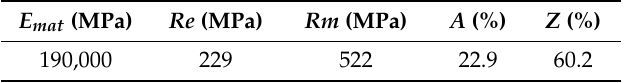
Table 4. Mechanical properties of the evaluated set AISI 316/316L.